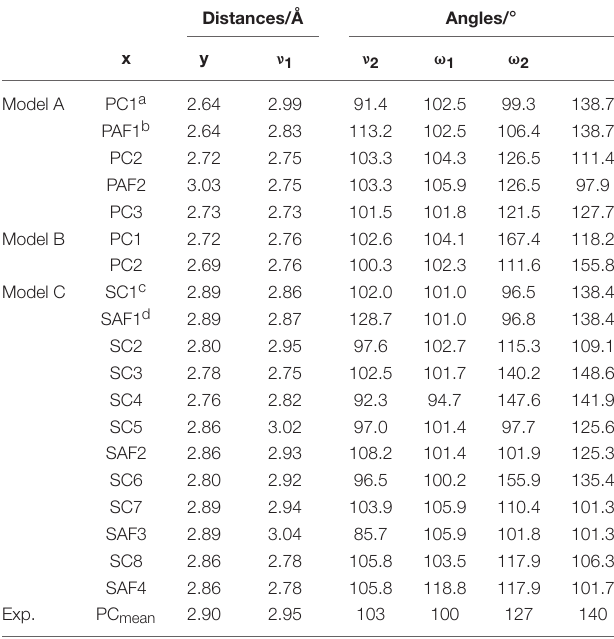
TABLE 5 | Distances (in Ångström) and bond angles (in degree) involved in the formation of non-covalent interactions for models A–C. Distances/Å Angles/